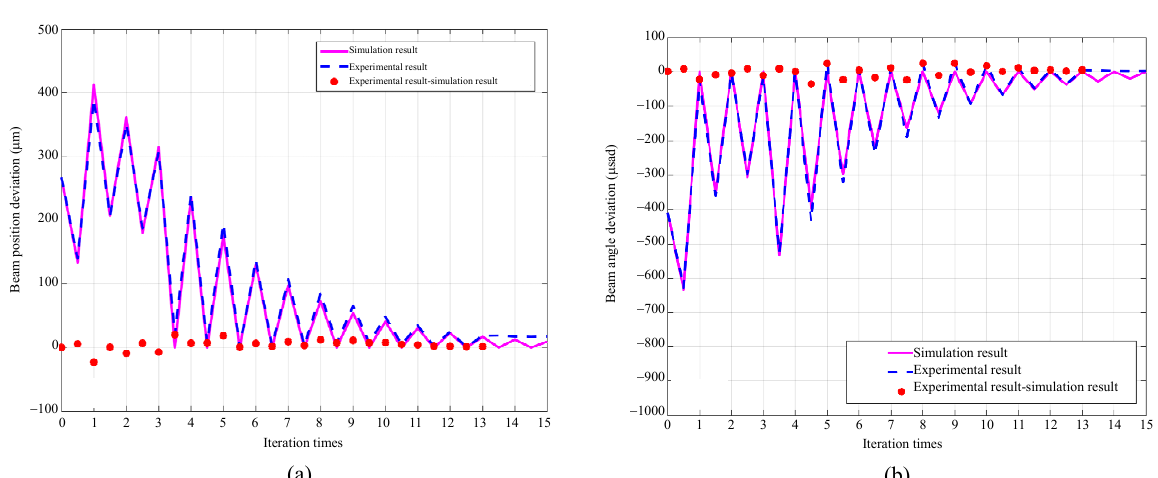
Fig. 4 Experimental and simulation results for the beam position and angle deviation changes with the combined two-stage iterative algorithm: (a) and (b) show the beam position and angle deviations, respectively.